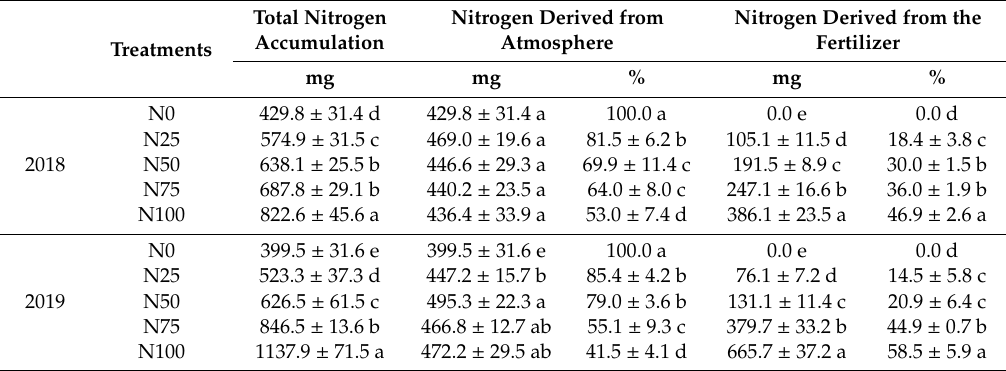
Table 7. Accumulation and ratio of nitrogen derived from di ff erent sources in soybean plants of experiment